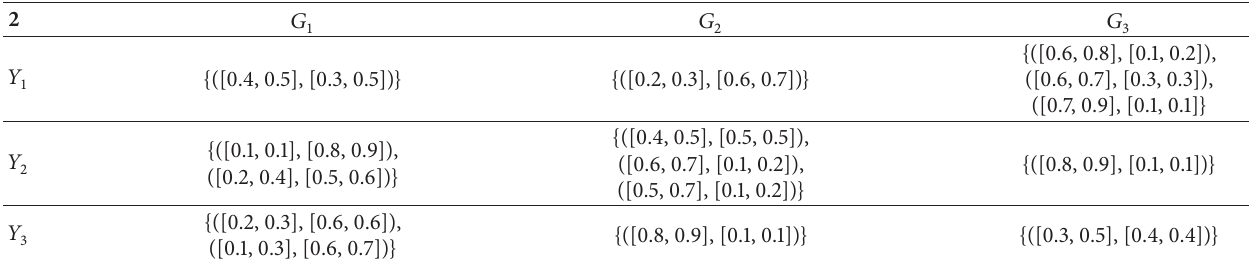
̃𝑅 (1) provided by 𝐷 1 .